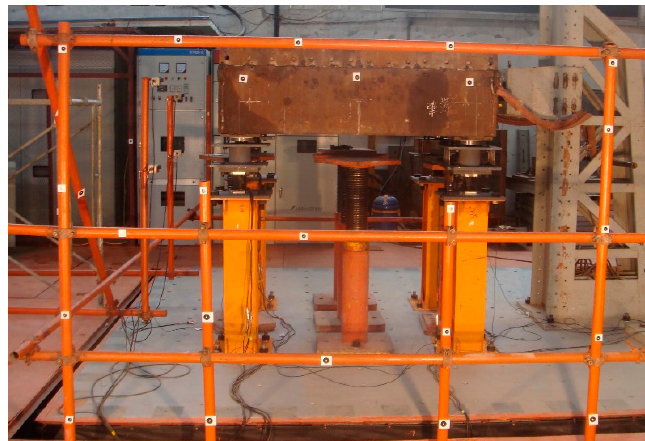
Figure 4. The control points attached on the stationary steel-pipe framework and the tracking points attached on the mass block.